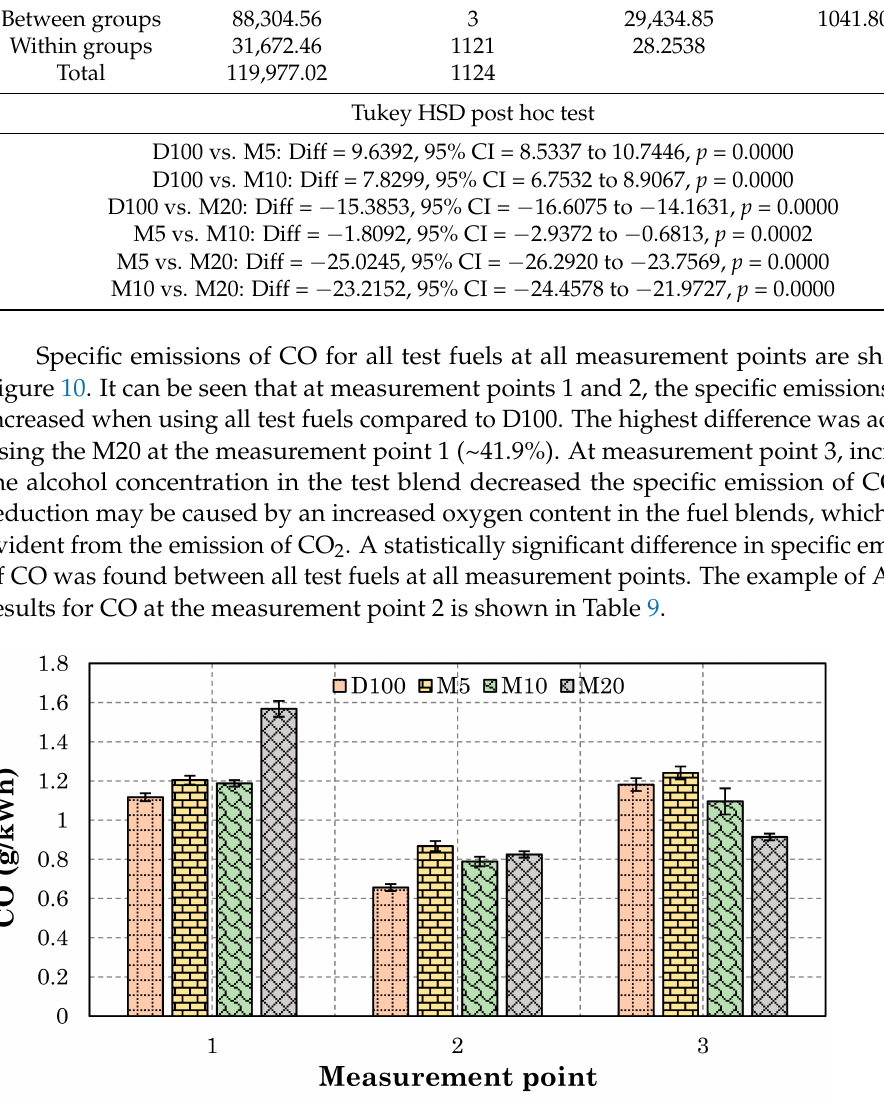
Figure 10. Specific emissions of CO for all test fuels at all measurement points (error bars represent the standard